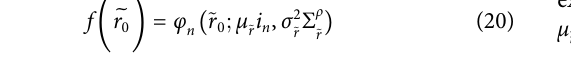
Frontiers in Applied Mathematics and Statistics |